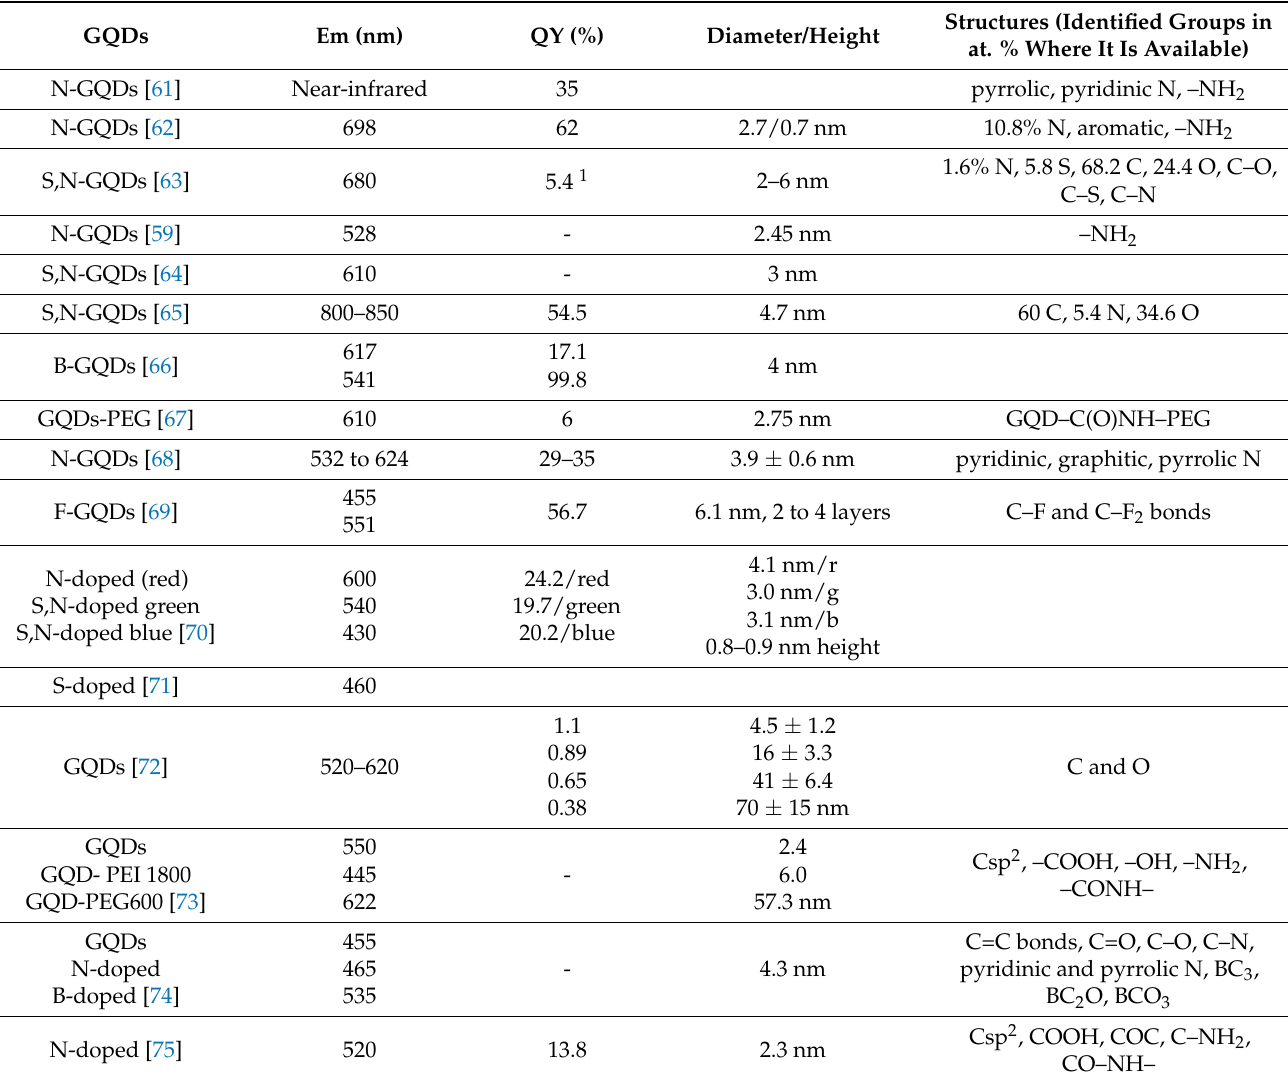
Table 2. GQDs properties: position of emission center (Em in nm) and colors, PL QY, diameter and height, and main structural